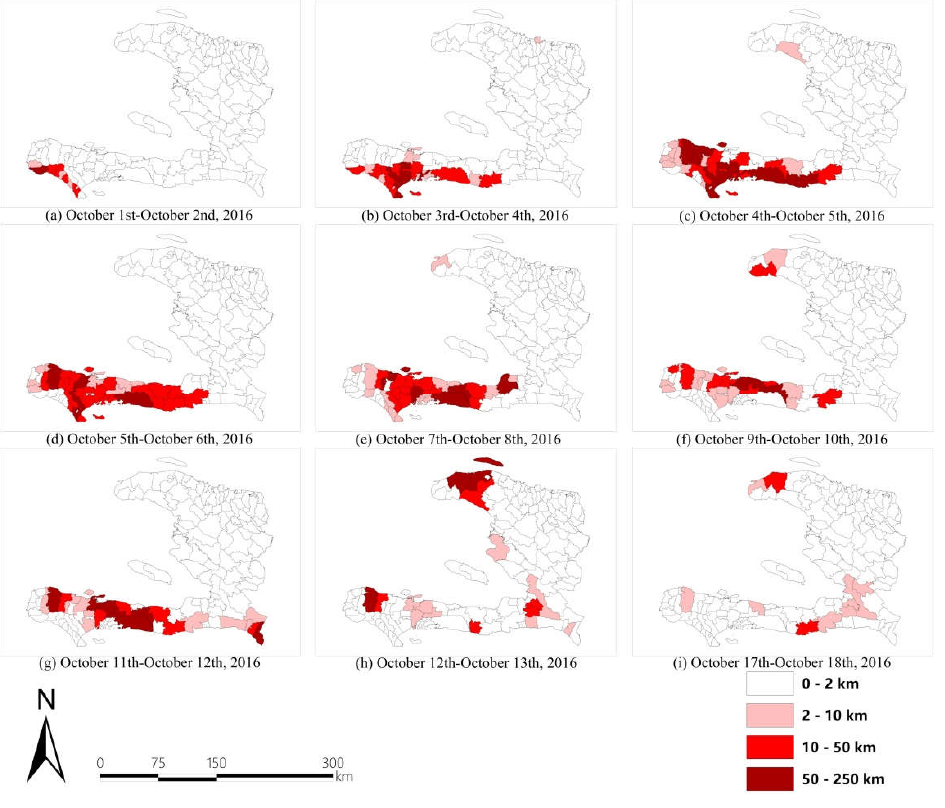
Figure 3. Length of roads updated in every commune in Haiti.